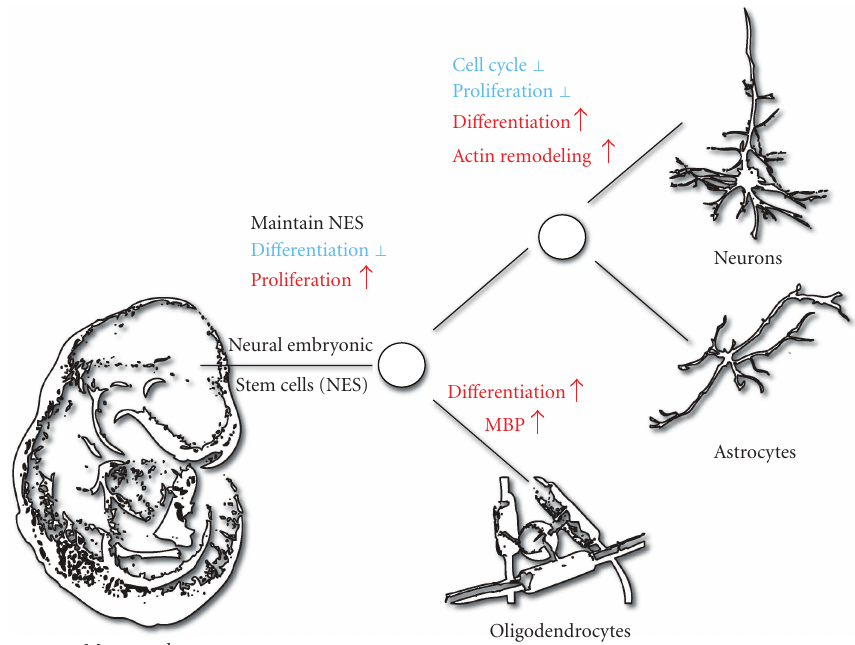
Figure 2: PPAR β potential role in neural cell di ff erentiation during development. PPAR β is expressed in the embryo and in the di ff erentiating cells of the CNS and plays important role for the maintenance and/or di ff erentiation of neural stem cells (NSC). PPAR β maintains NSC in an undi ff erentiated proliferative status [45]. Once the NSC cells have started to di ff erentiate, PPAR β could play a role in (1) neuronal di ff erentiation, inducing the morphological characteristics and the gene expression patterns of neuronal cells, (2) promoting the oligodendrocyte precursor cells (OPC) di ff erentiation [46], strongly expressing PPAR β [47], to mature oligodendrocytes [7]. In promoting di ff erentiation, PPAR β also influences cell cycle and proliferation rate. Up to today no role has been clearly established for PPAR β in astrocyte di ff erentiation. ( ↑ Activation in red, ⊥ Repression in